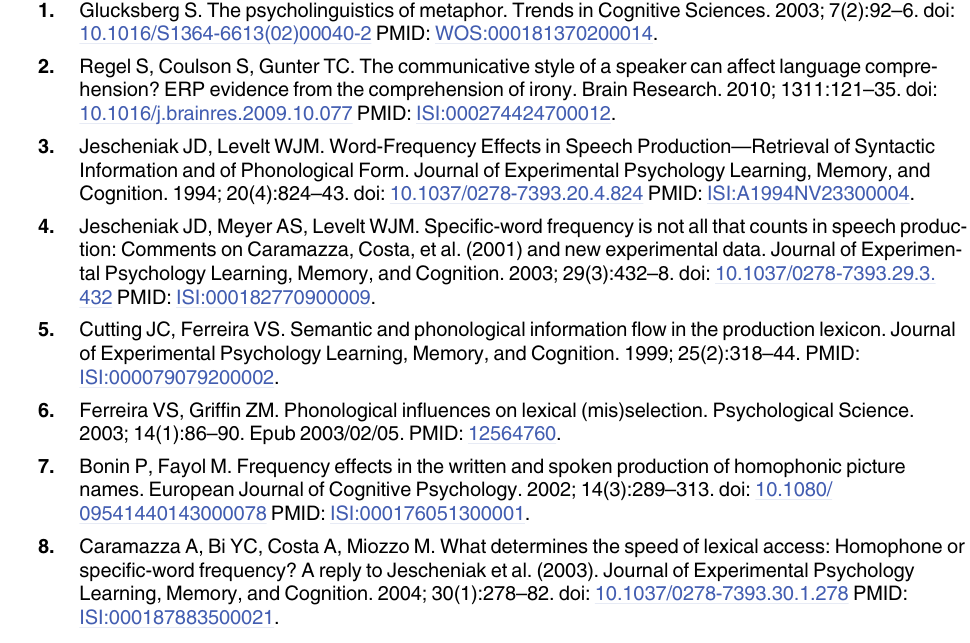
S3 Table. Correlations of fixed effects of the overall LMM. S4 Table. Correlations of fixed effects of the subsequent LMMs separated for the related and unrelated prime